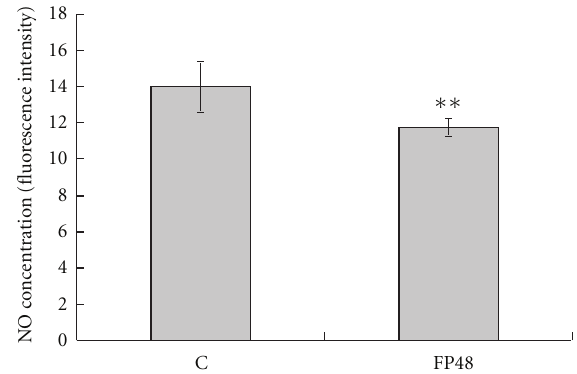
Figure 4: Comparison of intracellular NO between the control (group C) and cFIR (group FP48) groups. Expression values are the mean and standard deviation, and the statistical di ff erence was detected by the Wilcoxon test.